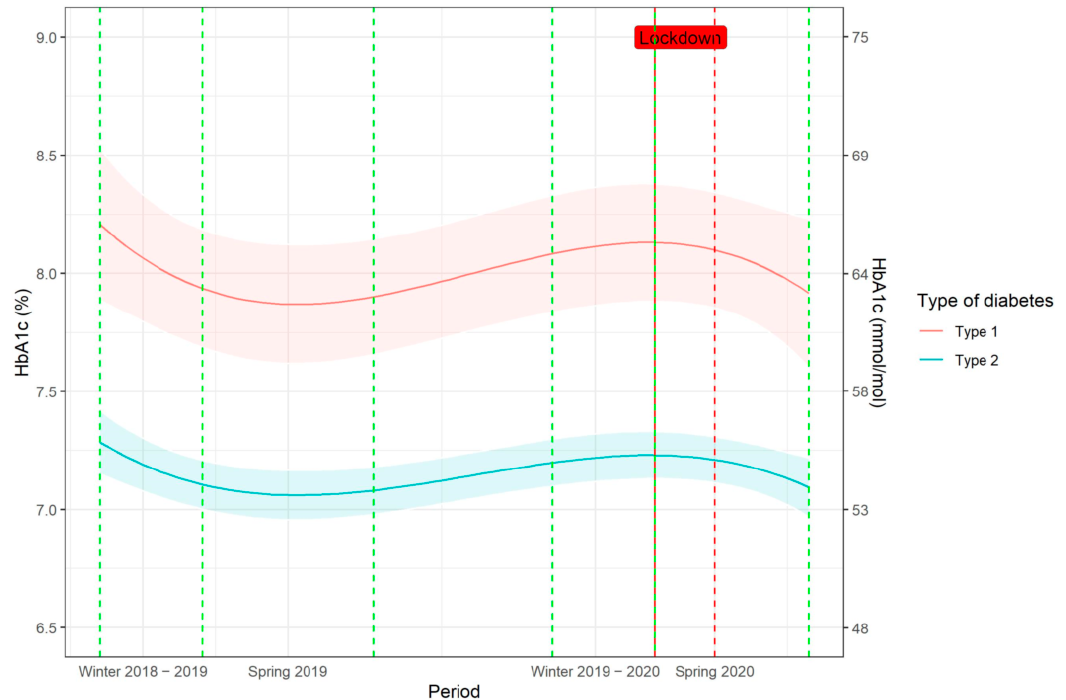
Figure 3. Seasonal variation of HbA1c in patients with type 1 diabetes mellitus ( n = 145) and type 2 diabetes mellitus ( n = 925) expressed as fitted values HbA1c in observation period 16 December 2018–27 July 2020 corrected for repeated measurements within patients. The curves represent the fitted values and the coloured fields the 95% confidence interval of the estimates for each diabetes mellitus type. Vertical dashed green lines define the beginning and the end of the individual periods; while the vertical dashed red lines depict the beginning and end of the Swiss national lockdown (the line on the left also defines the beginning of the period spring 2020).